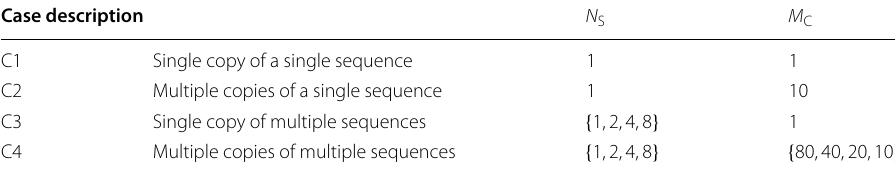
Table 1 5G NR RIM evaluation